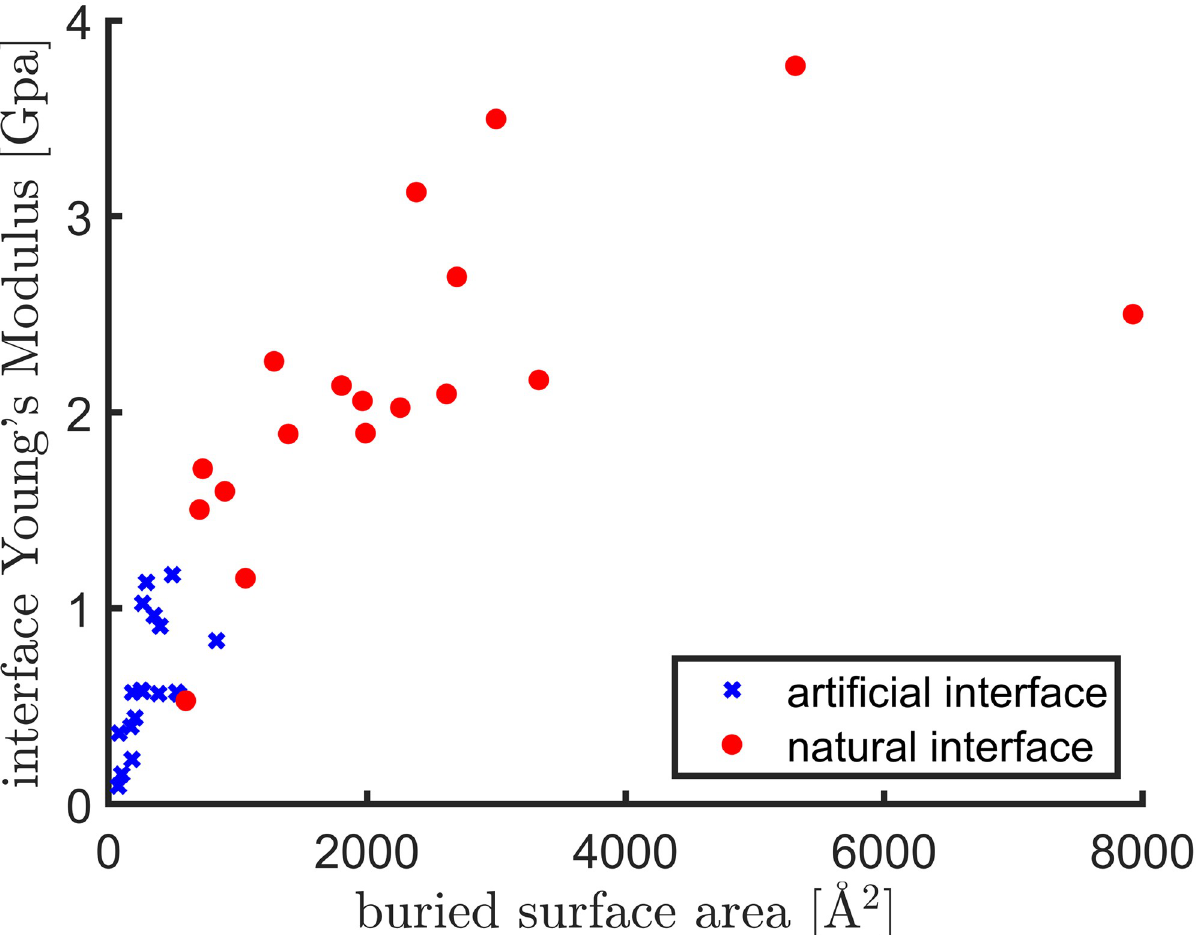
Fig 8. A scatter plot between the buried surface areas and the Young’s moduli of the interface regions, for both artificial (blue crosses, data points from Table 2) and natural (red solid circles, data points from Table 3) interfaces.